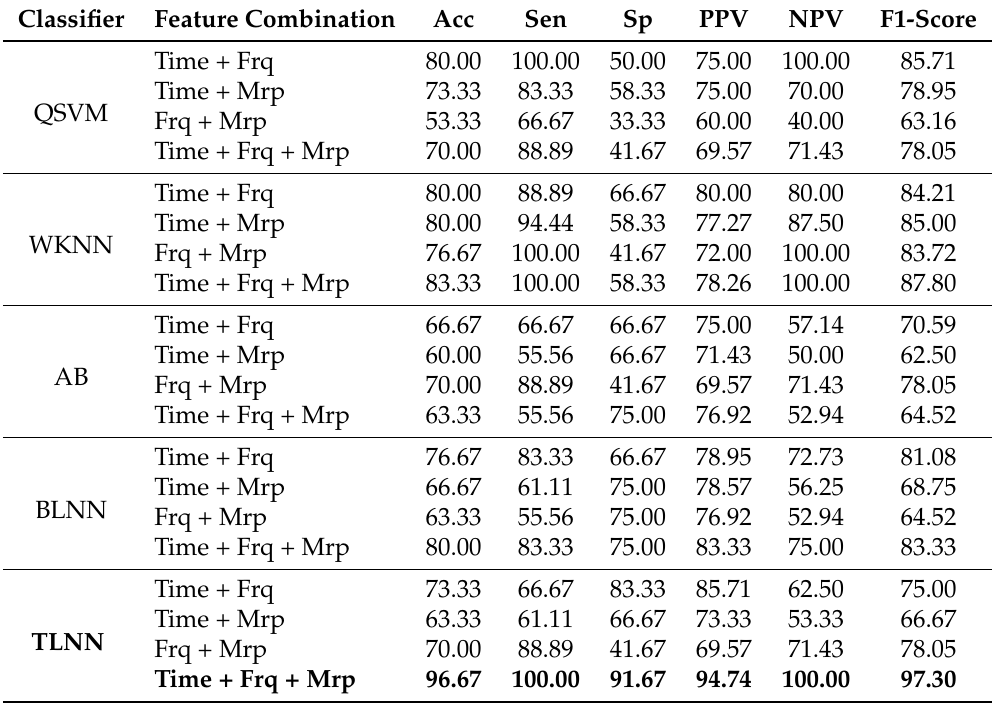
Table 5. Performance evaluation with combinations of time, frequency (Frq), and morphological (Mrp) features using different classifiers for Experiment 1 (no pain vs. high pain). (QSVM: Quadratic- SVM, WKNN: Weighted-KNN, AB: AdaBoost, BLNN: Bi-layered Neural Network, TLNN: Tri-layered Neural Network). Bold text indicates the best results.